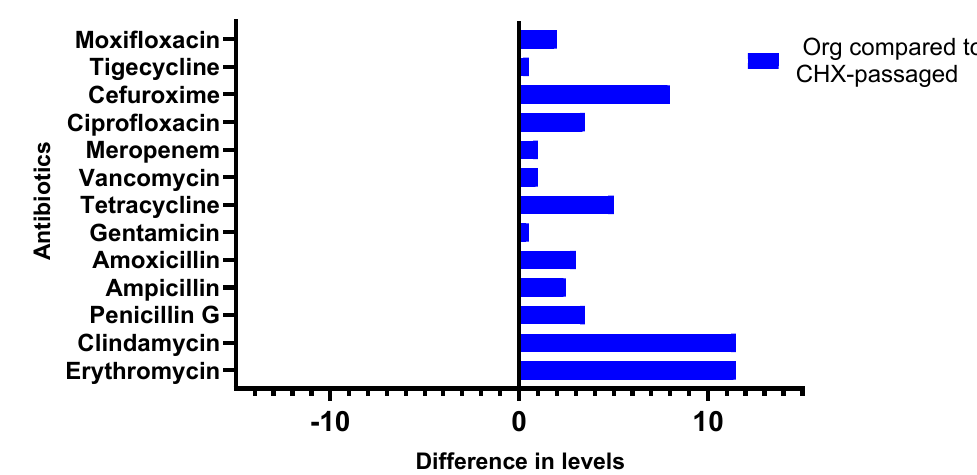
Figure 7. Antibiotic susceptibility testing of G. adiacens isolates from Subject 5. Graphical depiction of the difference in susceptibilities in levels between the original isolate and the isolates after passaging with CHX. The levels are drawn on the X-axes, and the antibiotics are shown on the Y-axes. P5: Proband 5.